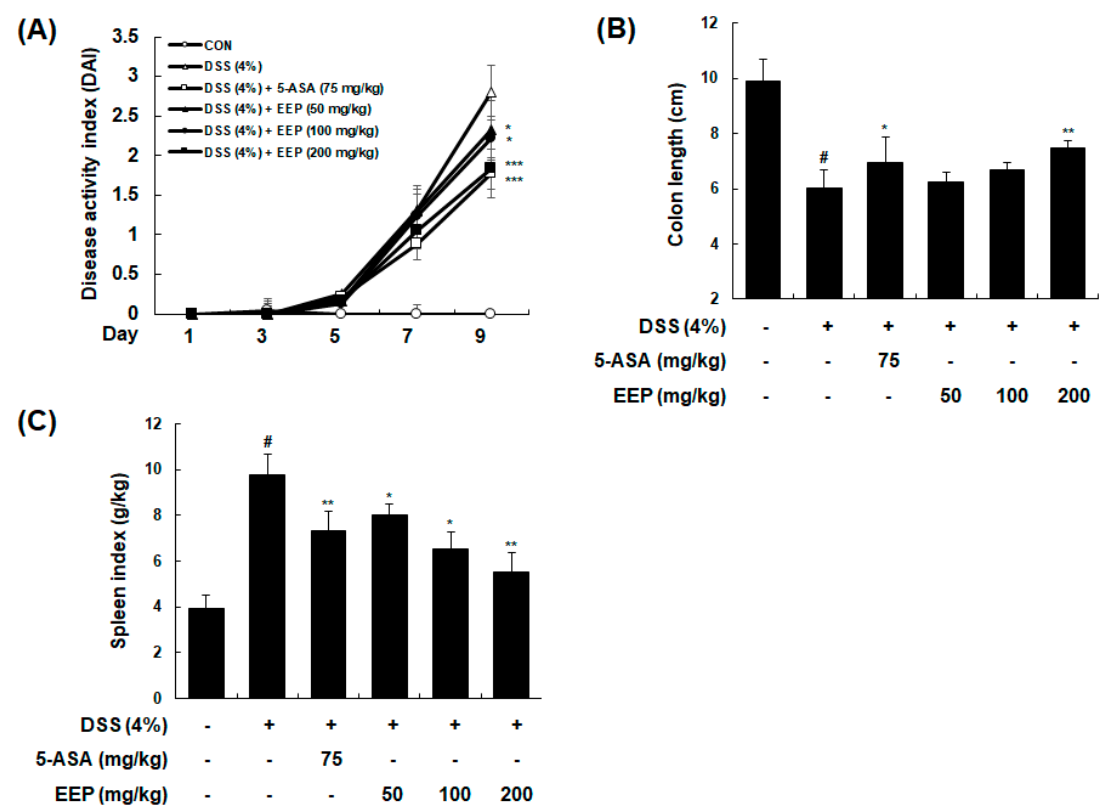
Figure 2. Effects of EEP on clinical signs of DSS-induced colitis mice. Mice were administered 4% DSS in drinking water (ad libitum) for 9 days with or without EEP (50, 100, or 200 mg/kg/day p.o.). 5-ASA (75 mg/kg/day p.o.) was used as a positive control. On day 9, mice were sacrificed and their colons and spleens were collected. ( A ) Changes in DAI levels were evaluated daily throughout the 9 days of administration period. ( B ) Length of colons and ( C ) weight of spleens were measured. Values are presented as means ± SDs ( n = 10). # p < 0.05 compared with vehicle-treated control group, and * p < 0.05, ** p < 0.01, *** p < 0.001 compared with DSS-induced colitis group.